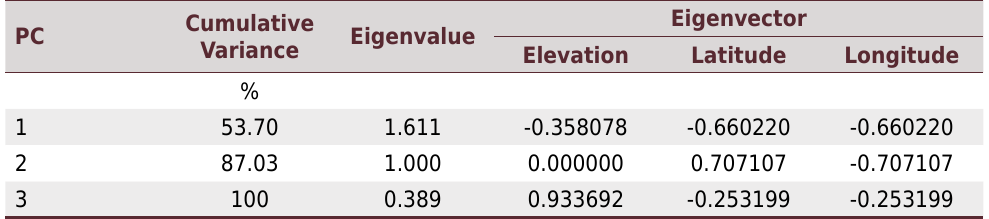
Table 1. Results of principal component analysis (PCA) on elevation, latitude, and longitude